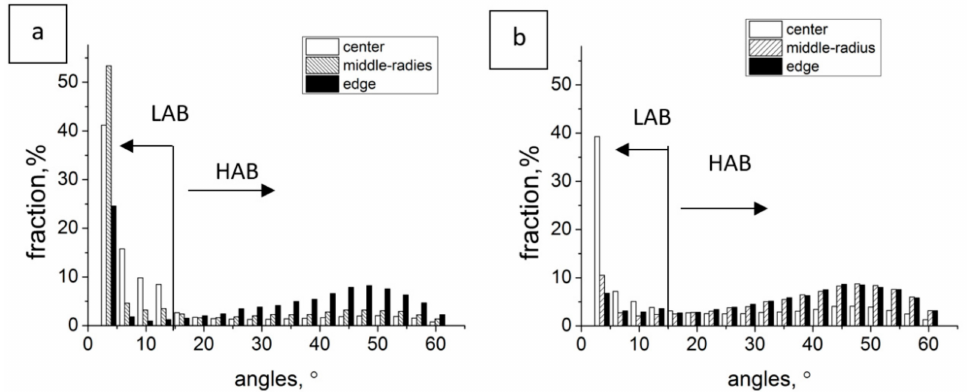
Figure 5. GB misorientation distributions after HPTE in the ( a ) transverse and ( b ) longitudinal sample